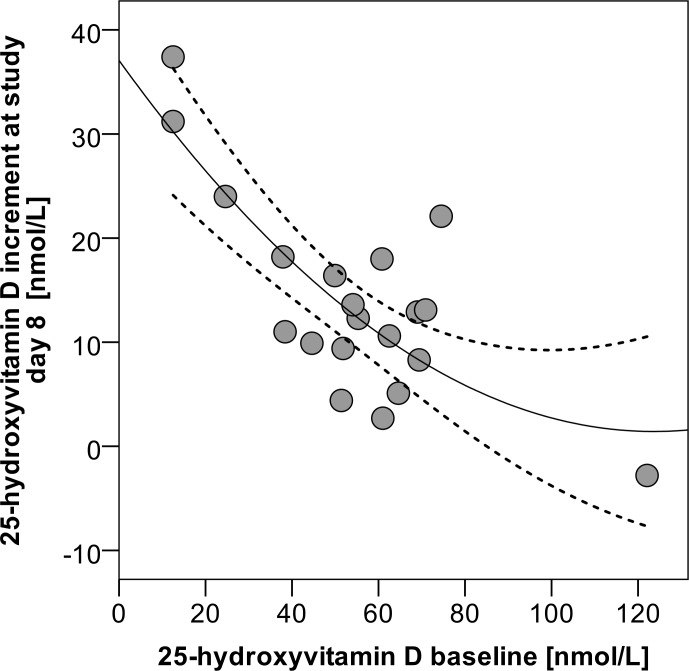
Scatterplot diagram, relationship between increase in 25-hydroxyvitamin D at day 8 and baseline 25-hydroxyvitamin D levels (quadratic regression analysis, r2 = 0.607, p<0.001) The solid line is the quadratic fit, and dashed lines are the 95% confidence limits to the fit.